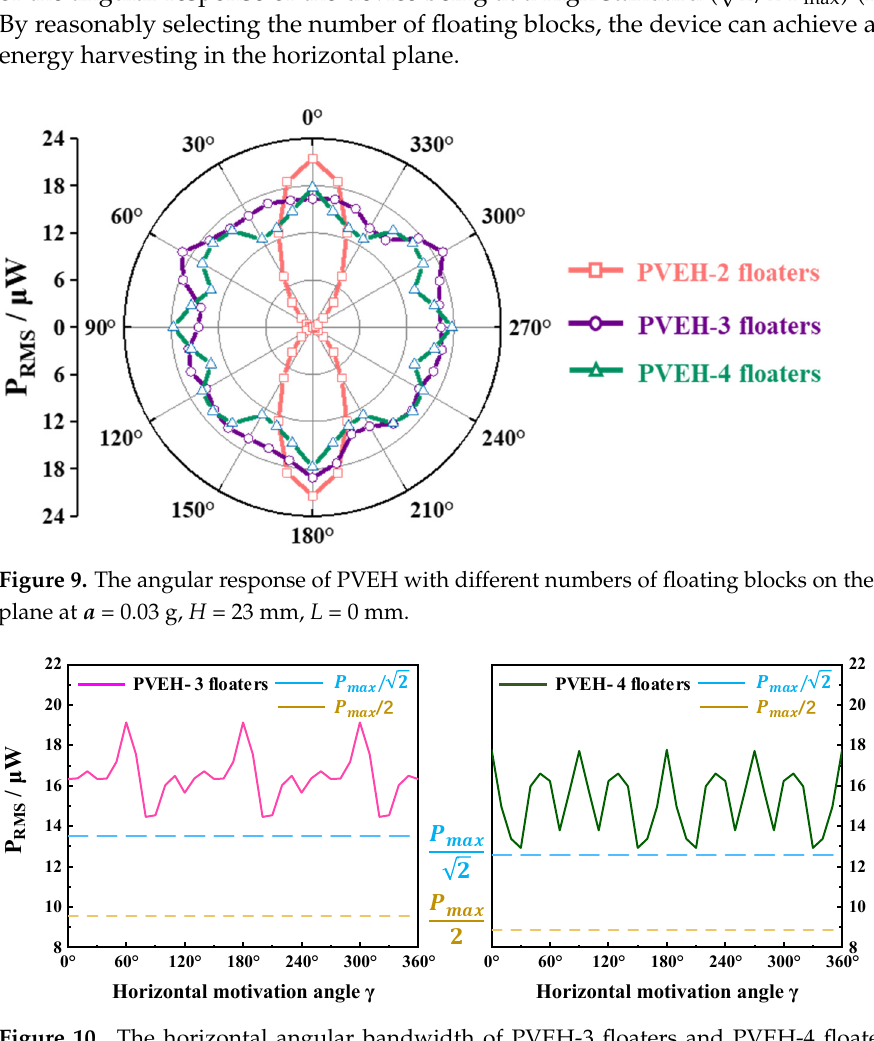
Figure 10. The horizontal angular bandwidth of PVEH-3 floaters and PVEH-4 floaters at their respective resonant frequencies.